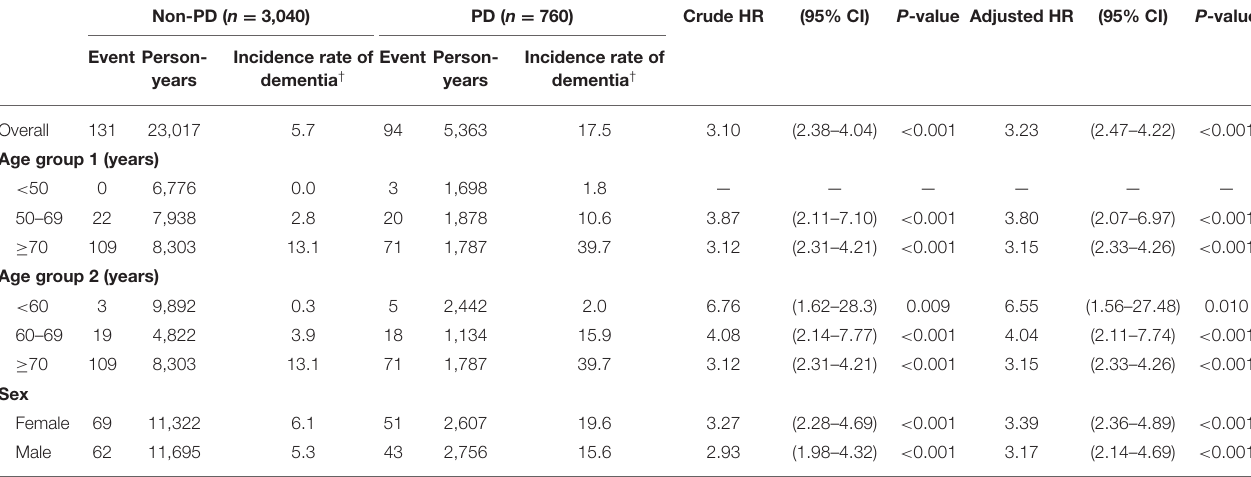
TABLE 2 | Incidence rate and hazard ratio of dementia associated with PD in Cox’s regression analysis, as stratified by age or sex. Non-PD ( n = 3,040)